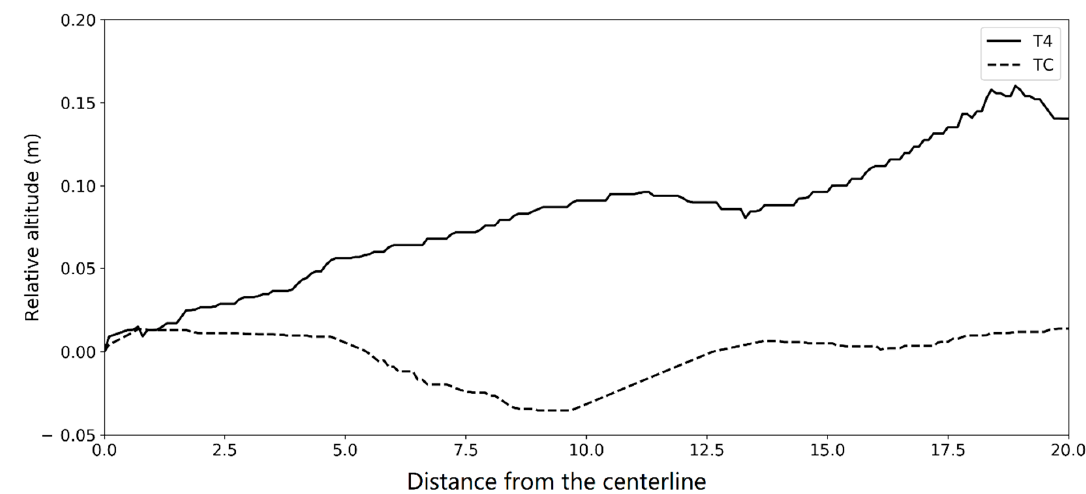
Figure 7. The mean relative altitude of 500 transect lines on the downwind areas of Treatment 4 (T4) and Treatment Control (TC).